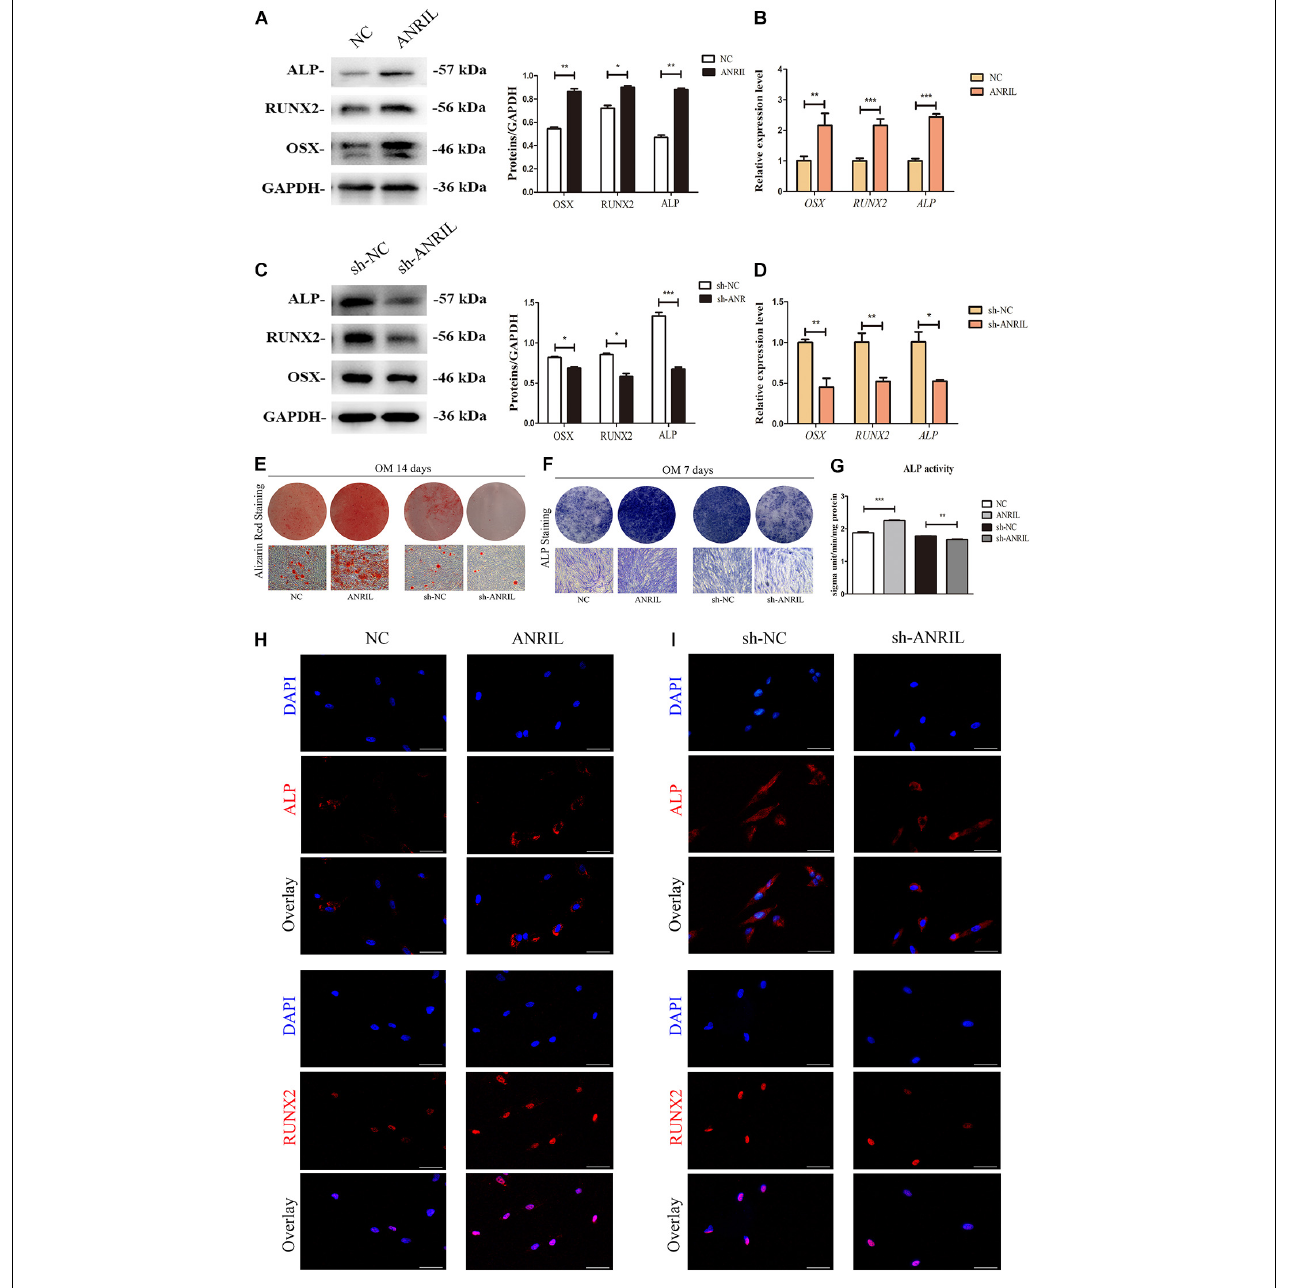
FIGURE 2 | LncRNA ANRIL regulates osteogenic differentiation of iPDLSCs. (A–D) ALP/ ALP , RUNX2/ RUNX2, and OSX/ OSX expressions were measured by western blot and qRT-PCR on day 7 after osteogenic induction. GAPDH served as an internal control. (E–G) Osteogenic differentiation of iPDLSCs was determined by Alizarin Red S, ALP staining and ALP activity assay at 14 and 7 days after osteogenic induction. (H,I) The expressions of ALP and RUNX2 in transfected iPDLSCs were also determined by immunofluorescence assay (Scale Bar = 50 µ m) (* P < 0.05, ** P < 0.01, *** P < 0.001).